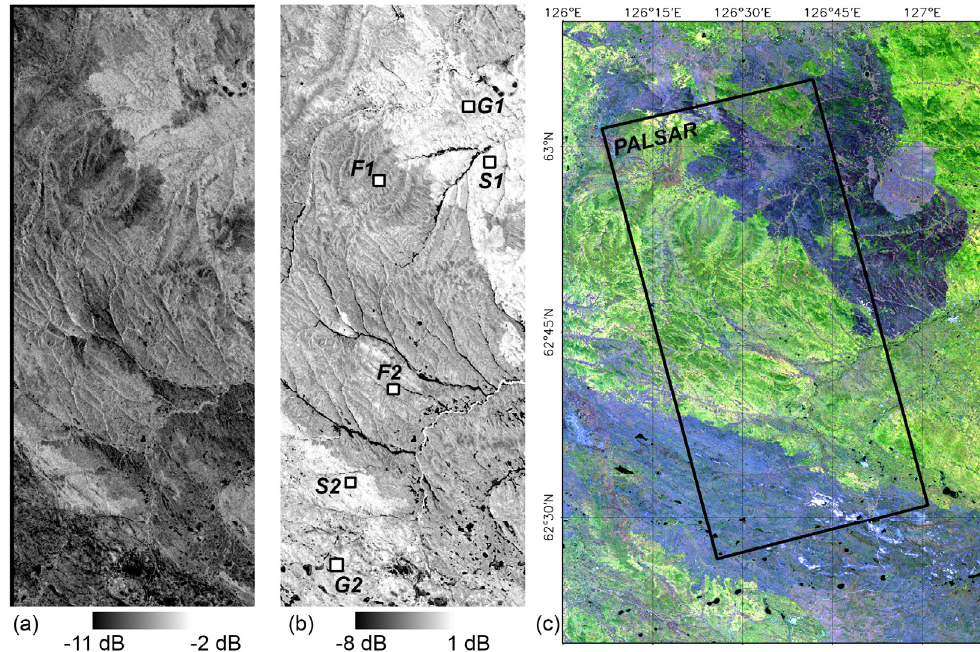
Figure 2. ALOS PALSAR total power images acquired on ( a ) 16 March 2007 (frozen conditions) and ( b ) 16 May 2007 (thawed conditions); ( c ) a Landsat TM image (Bands 3, 2, 1 in RGB) acquired on 8 September 2007. F, forest; G, open ground; S, shrubland.